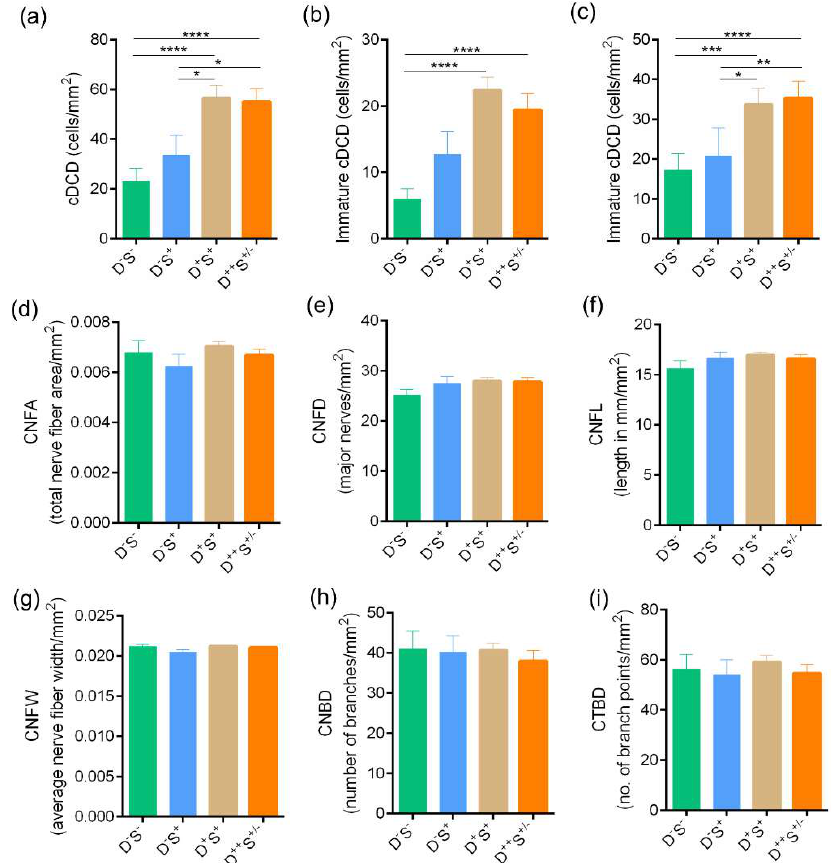
Figure 4. Corneal dendritic cell density and sub-basal nerve plexus features profile in subjects categorized based on discomfort concordance to signs (DCS) grouping strategy. Bar graphs represent ( a ) total corneal dendritic cell density (cDCD), ( b ) density of immature forms of corneal dendritic cells, ( c ) density of mature forms of corneal dendritic cells, ( d ) corneal nerve fibre area— CNFA, ( e ) corneal nerve fibre density—CNFD, ( f ) corneal nerve fibre length—CNFL, ( g ) corneal nerve fibre width—CNFW, ( h ) corneal nerve branch density—CNBD and ( i ) corneal total branch density—CTBD determined using laser scanning in vivo confocal microscopic images in the study subjects grouped in the various categories based on DCS grouping strategy. The number of eyes analysed for corneal dendritic cell density are as follows: Group 1 (D - S - ): n = 58 eyes; Group 2 (D - S + ): n = 28 eyes; Group 3 (D + S + ): n = 127 eyes; Group 4 (D ++ S +/- ): n = 74 eyes. The number of eyes analysed for sub-basal nerve plexus features are as follows: Group 1 (D - S - ): n = 27 eyes; Group 2 (D - S + ): n = 17 eyes; Group 3 (D + S + ): n = 98 eyes; Group 4 (D ++ S +/- ): n = 55 eyes. * p < 0.05, ** p < 0.01, *** p < 0.001, **** p < 0.0001, Kruskal–Wallis test with Dunn’s multiple comparisons test was performed.